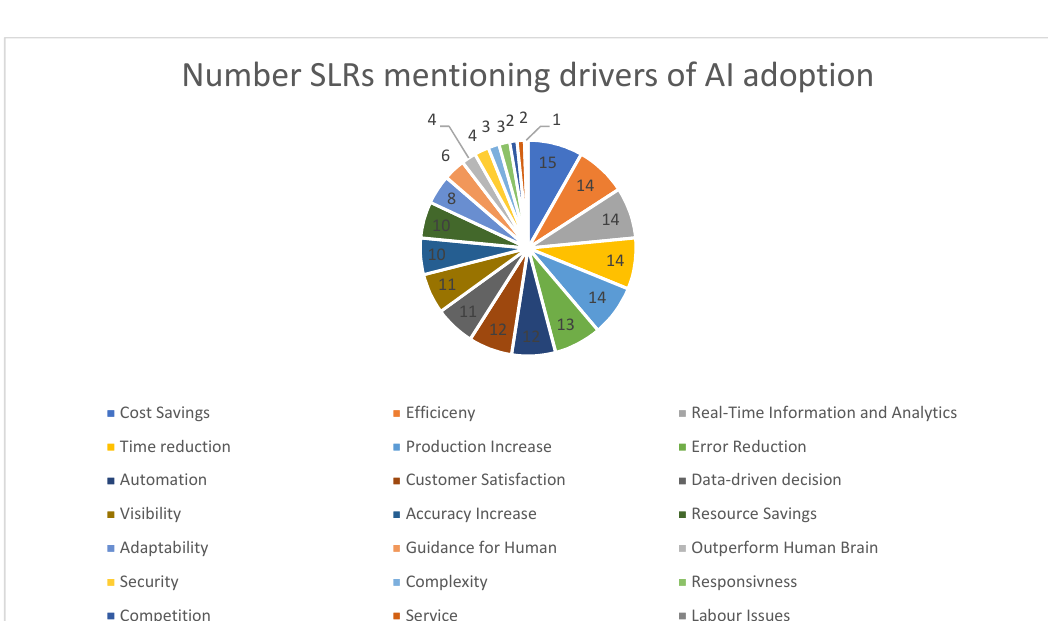
Figure 7. Drivers of AI adoption in SCM.